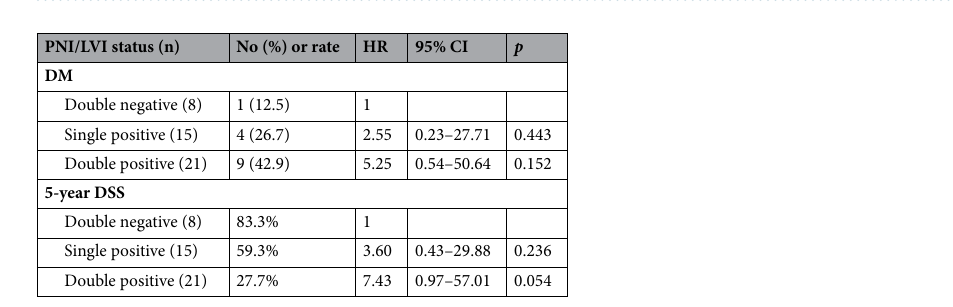
Table 6. DM and 5-year DSS to combines PNI and LVI status in 44 LN+ patients. PNI perineural invasion, LVI lymphovascular invasion, LN + neck metastasis, DM distant metastasis, DSS disease-specific